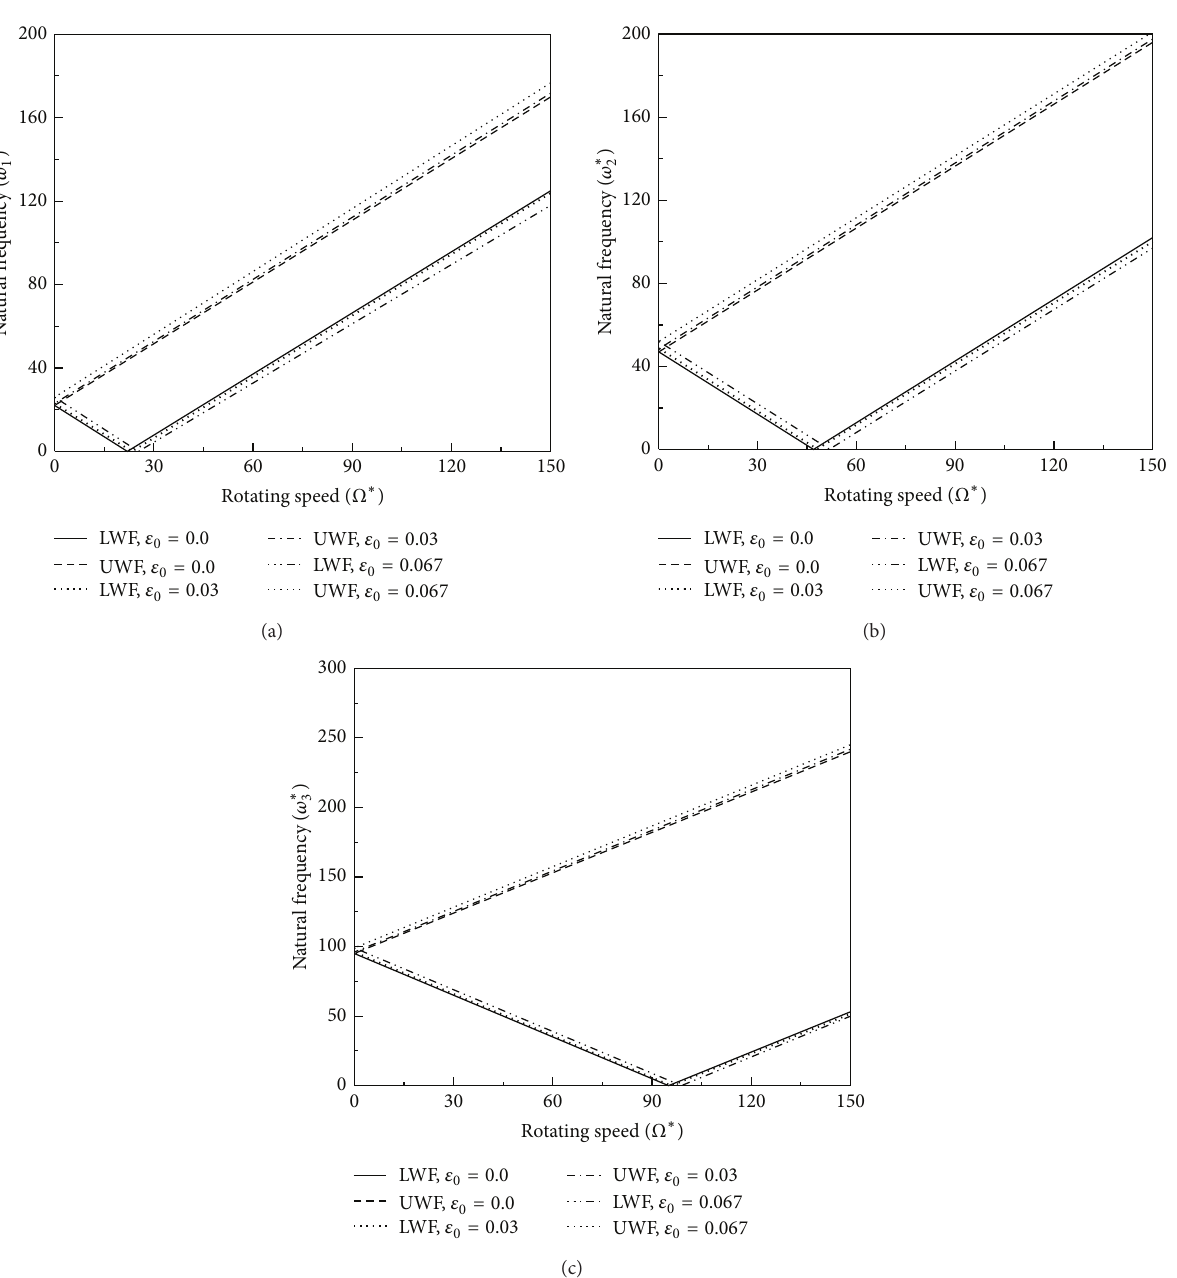
corresponds to the dynamical instability of the rotating